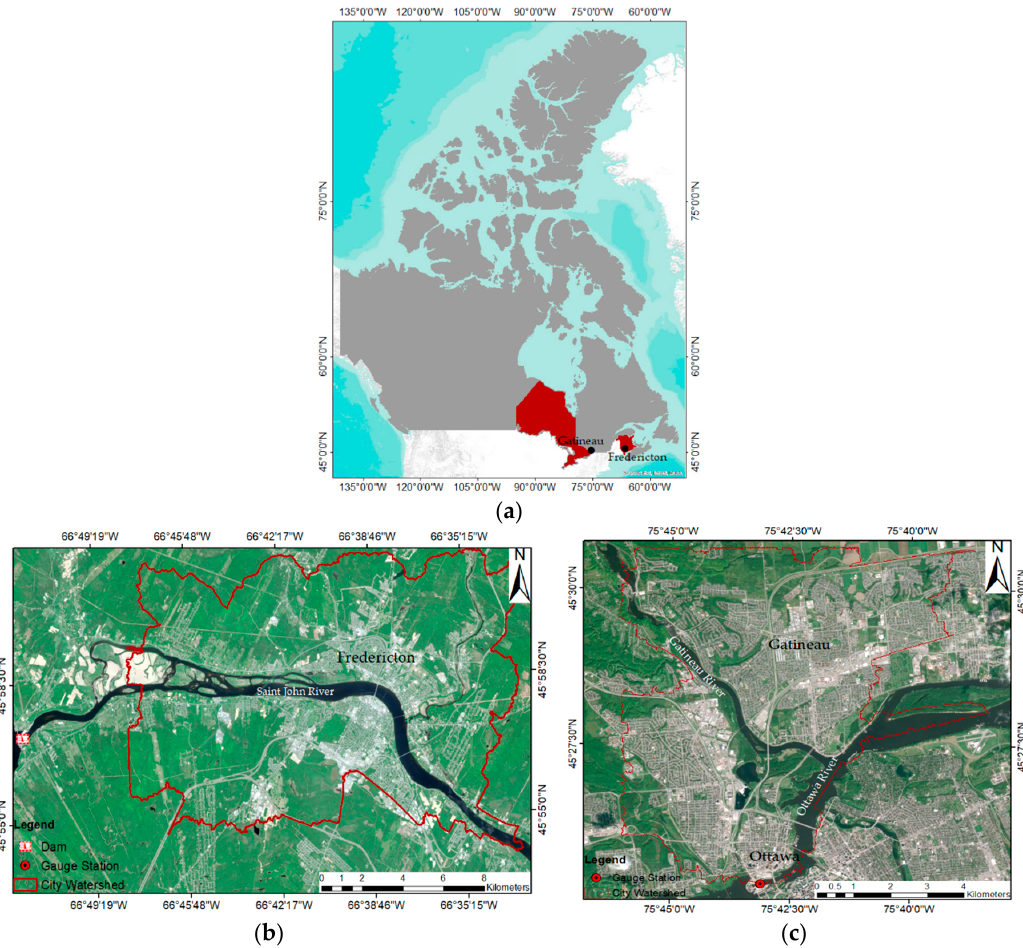
Figure 1. Study areas of this paper: ( a ) map of Canada with the provinces of study highlighted in red and Fredericton and Ottawa cities highlighted with black dots. More details are provided by Stinel-2 satellite images of ( b ) Fredericton and ( c ) and Gatineau study. The red borders in ( b ) and ( c ) show the extent of the study areas.